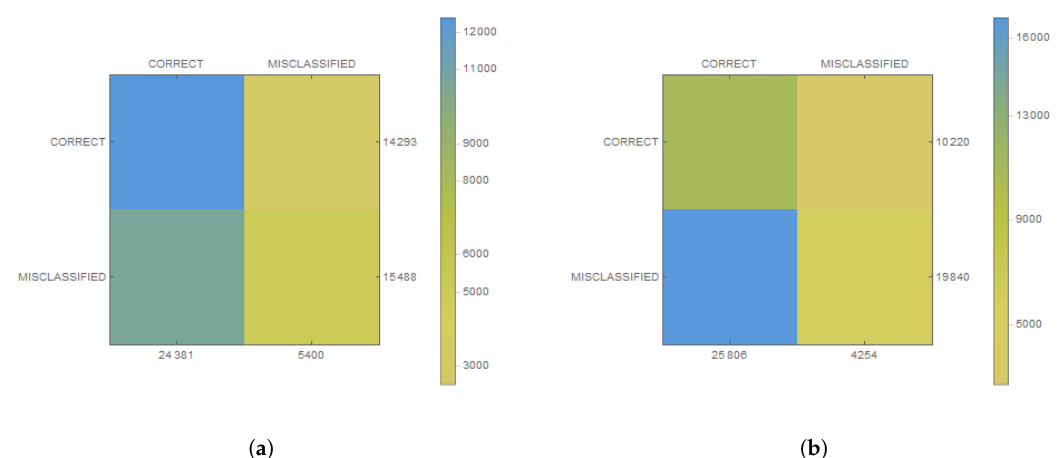
Figure 7. Confusion matrices for convolutional neural network: ( a ) watering flowers; and ( b ) taking out the